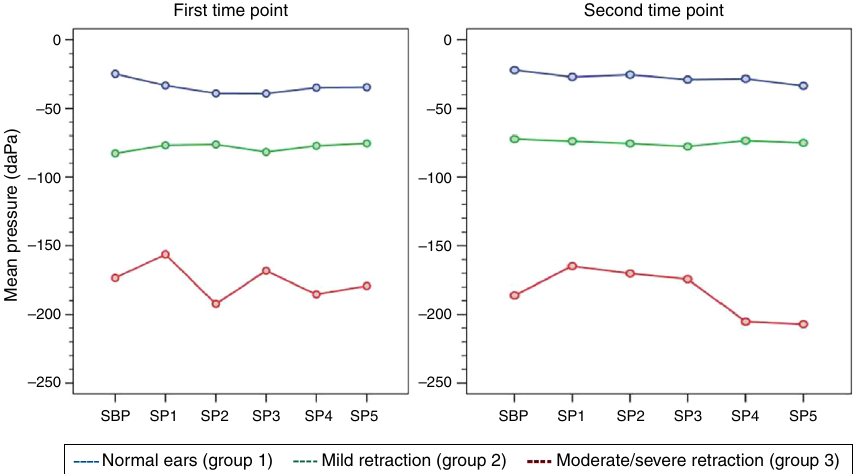
Variability of mean middle ear pressure measurements during the sniff test at the first and second time points of